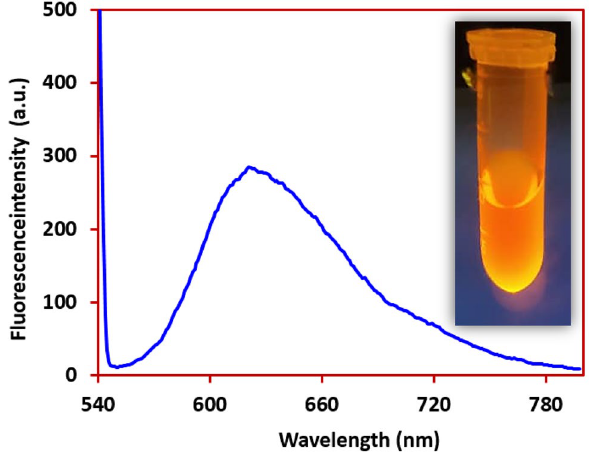
Figure 11. Fluorescent spectrum of DIMP and the photograph of DIMP (0.5 mM) using an ultraviolet lamp in CHCl 3 solvent measured under excitation of 535